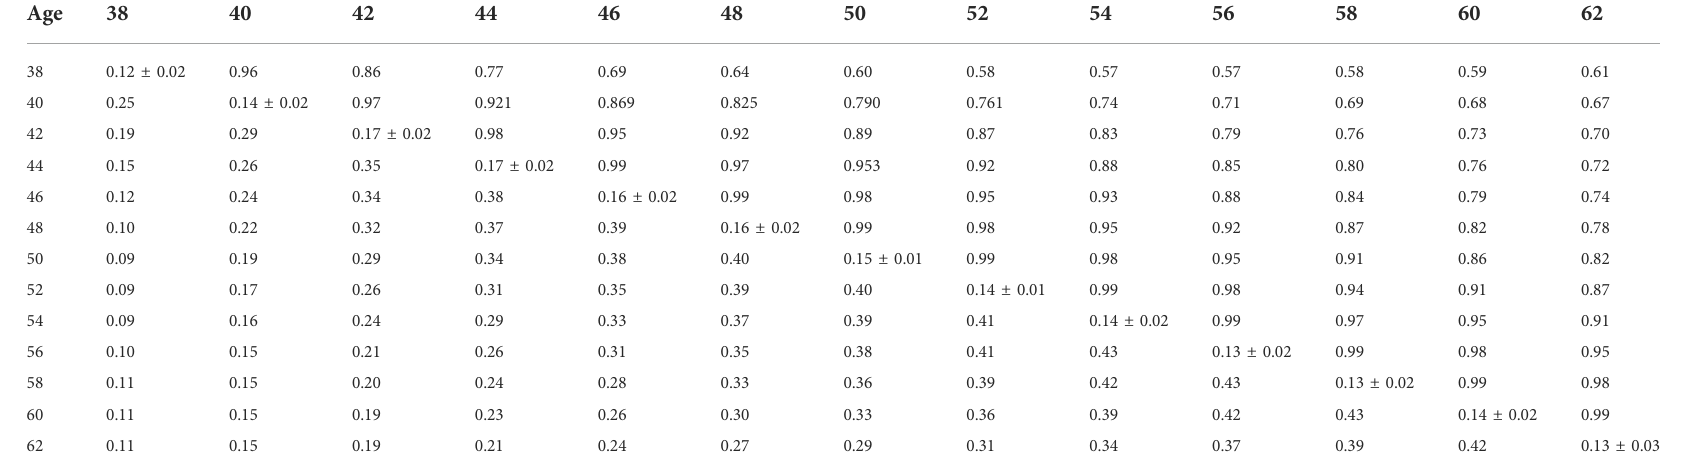
TABLE 7 Estimates of heritability (diagonal), phenotypic correlations (below diagonal), and genetic correlations (above diagonal) for hatch of fertile (HOF) using the pedigree random regression model. Age